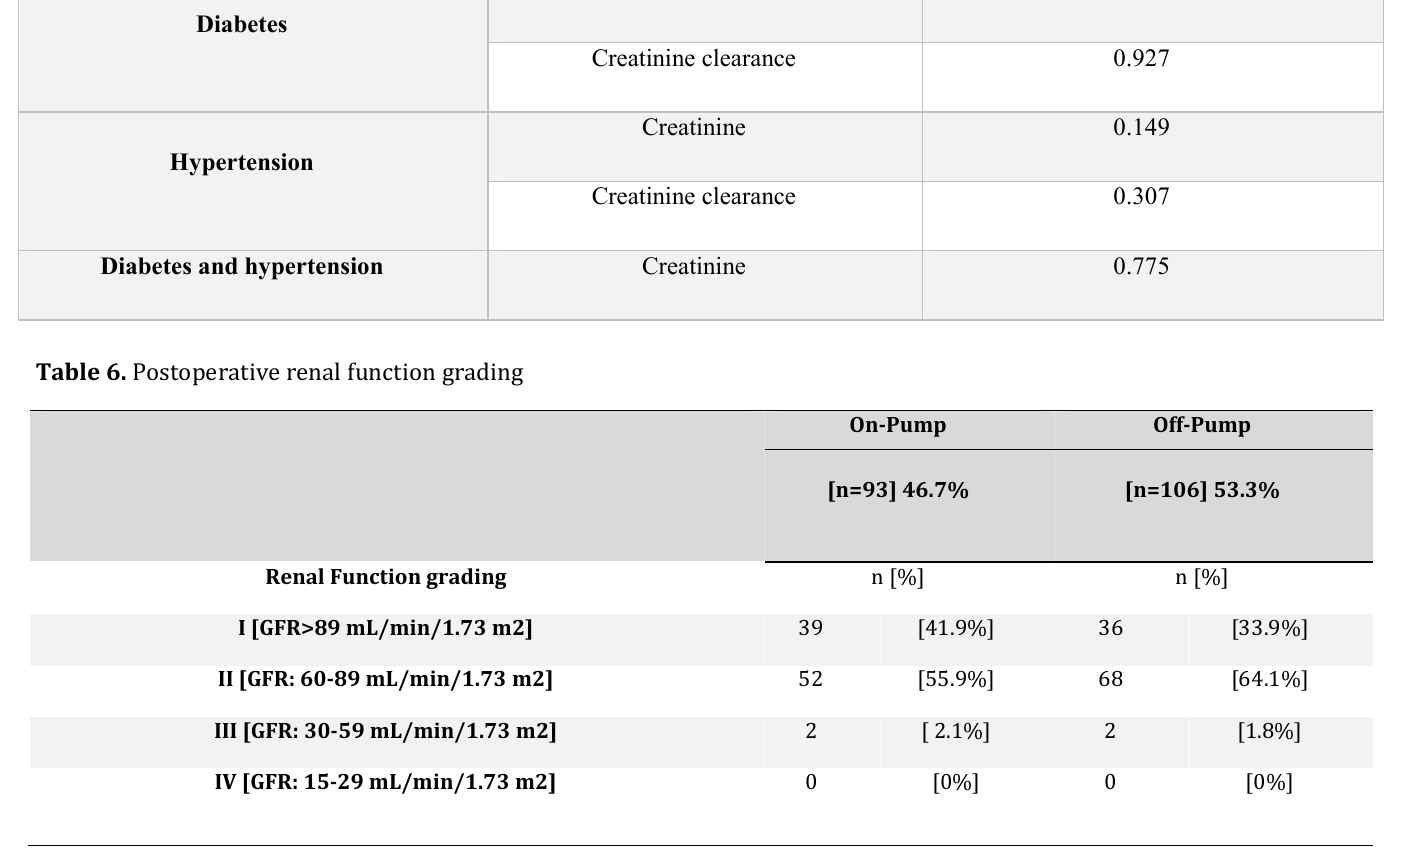
Table 5 . Comparison of postoperative significance of renal functions in diabetes, hypertension, as well as both diabetes and hypertension between two study groups